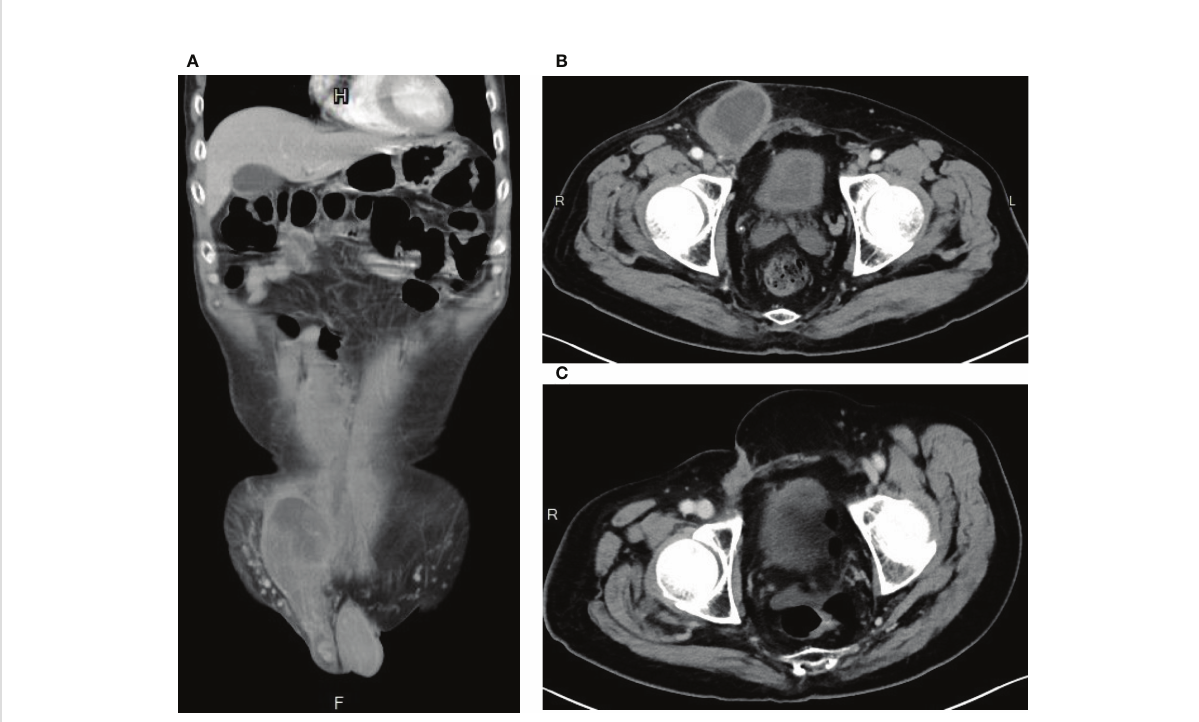
FIGURE 4 Computed Tomography images showing evidence of tumor shrinkage (A) after neoadjuvant radiotherapy plus conversion surgery, (B) after adjuvant chemotherapy AIM (ifosfamide, Mesna, and doxorubicin) and MAID (Mesna, doxorubincin, ifosfamide, and dacarbazine) regimens, and (C) after ifosfamide